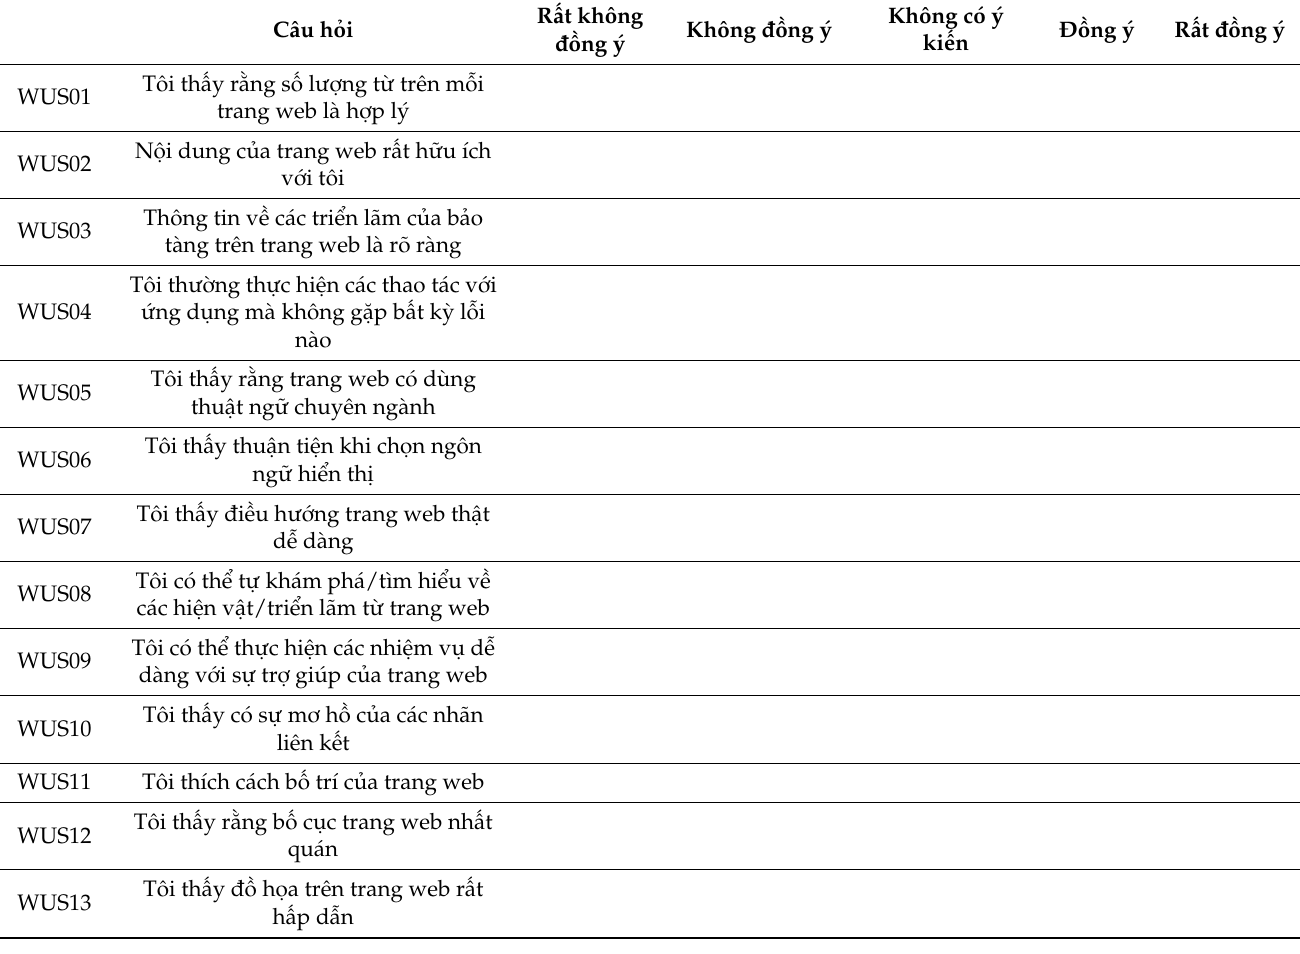
Table A4. B ả ng h ỏ i cho Trang web (Vietnamese version).